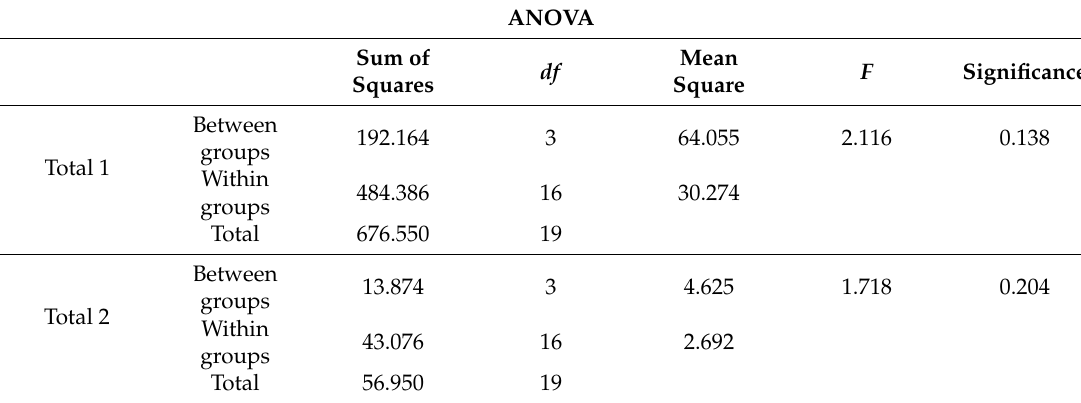
Table 5. ANOVA test.